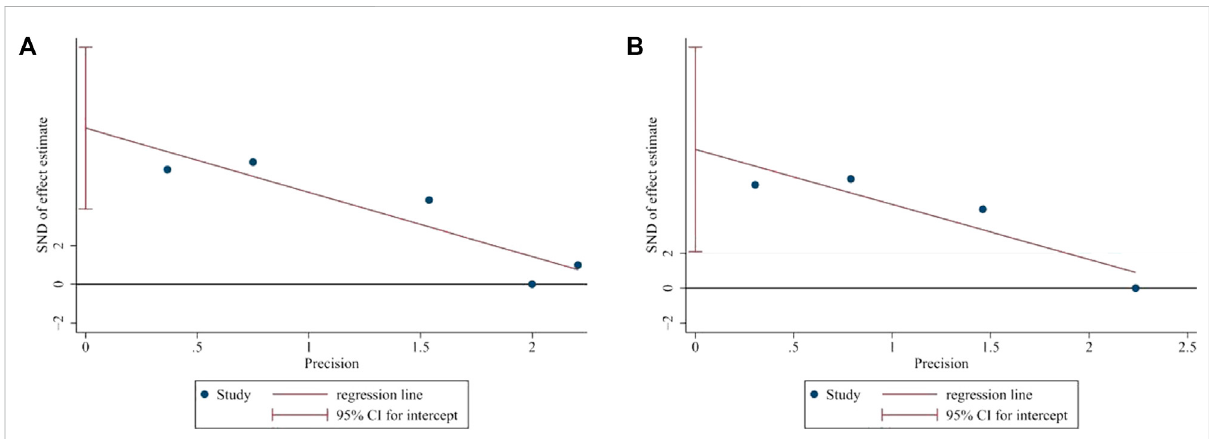
FIGURE 11 Publicationbias. (A) Egger ’ stestofBMD-femur. p =0.009,t=6.14. (B) Egger ’ stestofBMD-lumbar. p =0.028,t=5.84.Both (A) and (B) indicated that there was publication